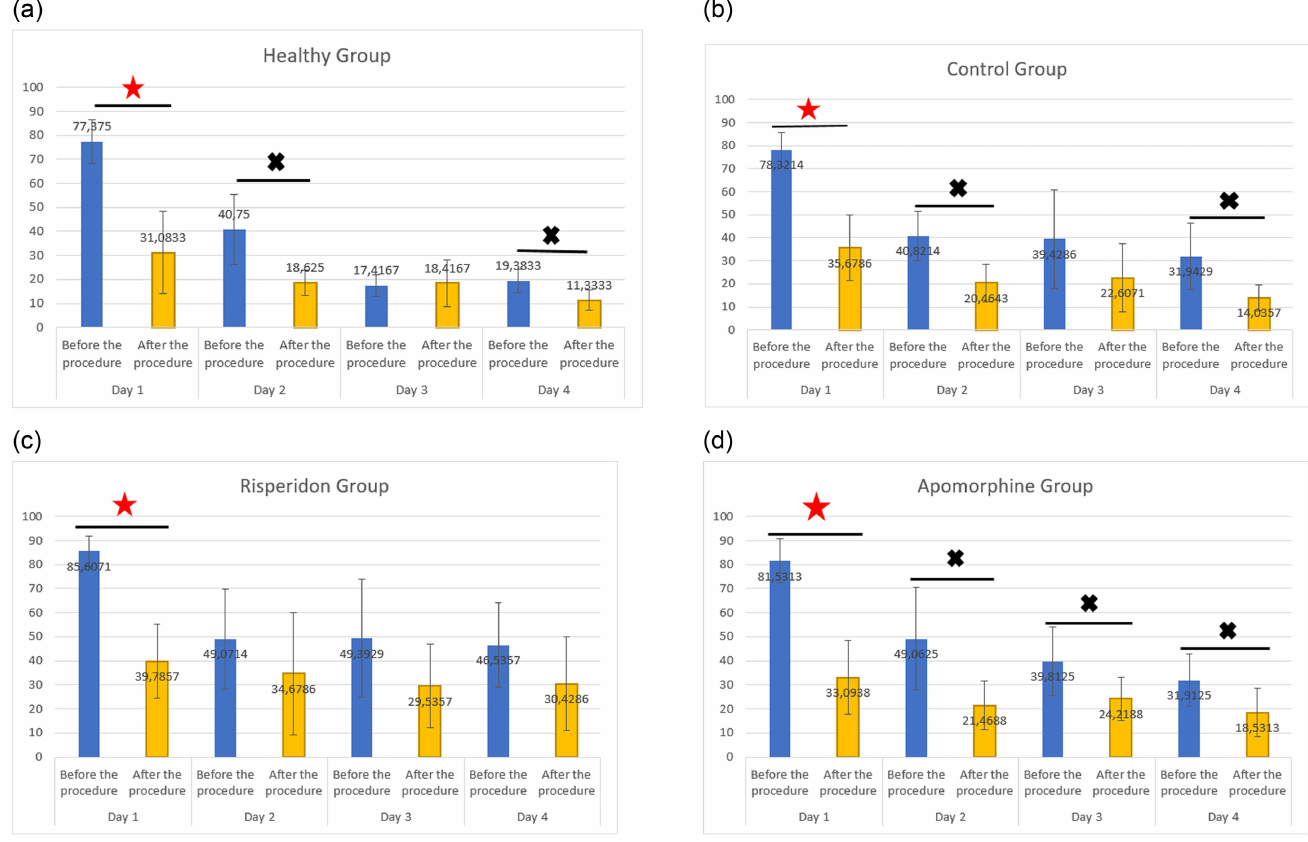
Figure 2. a-d. The comparisons of the first and last day data of healthy (a), control (b), risperidone (c), and apomorphine (d) groups according to Morris water maze tests. The asterisk and cross above the boxes indicate a statistically significant difference between these two groups. (asterisk: P < .001; cross: P < .05).